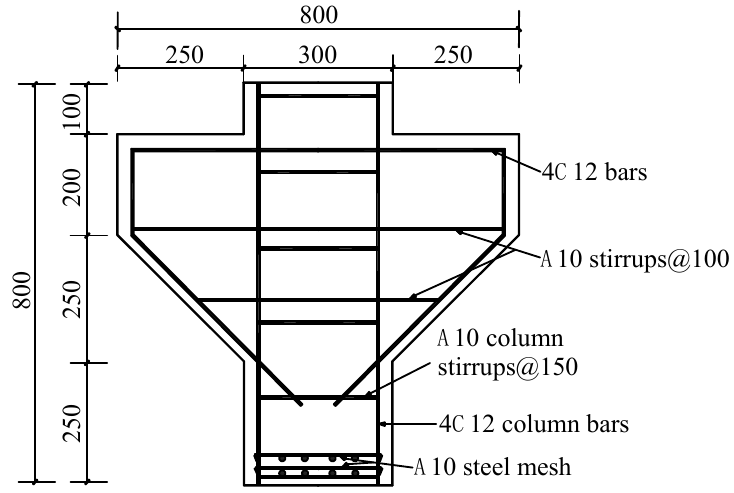
Figure 1. Dimensions of specimens and arrangement of reinforcement.